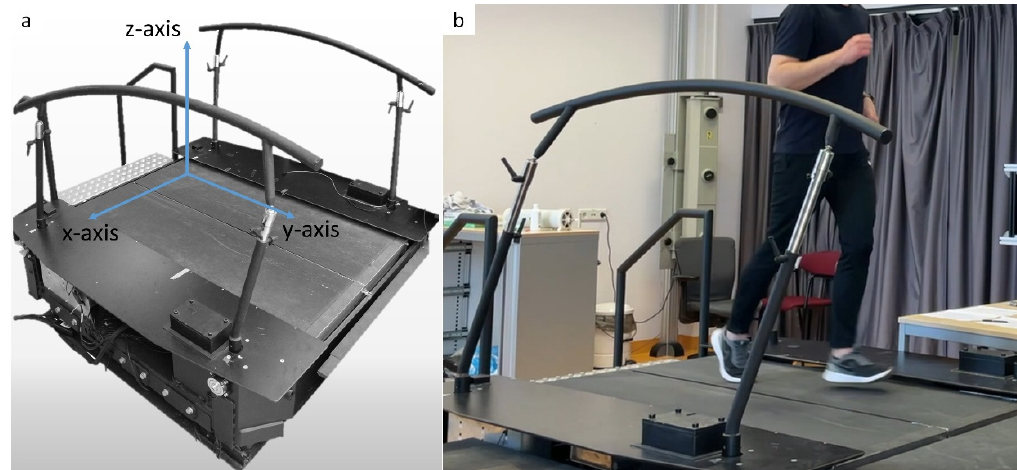
Figure 1. Instrumented treadmill. ( a ) The instrumented treadmill and the coordinate system of the embedded force plates. ( b ) The instrumented treadmill during a measurement.